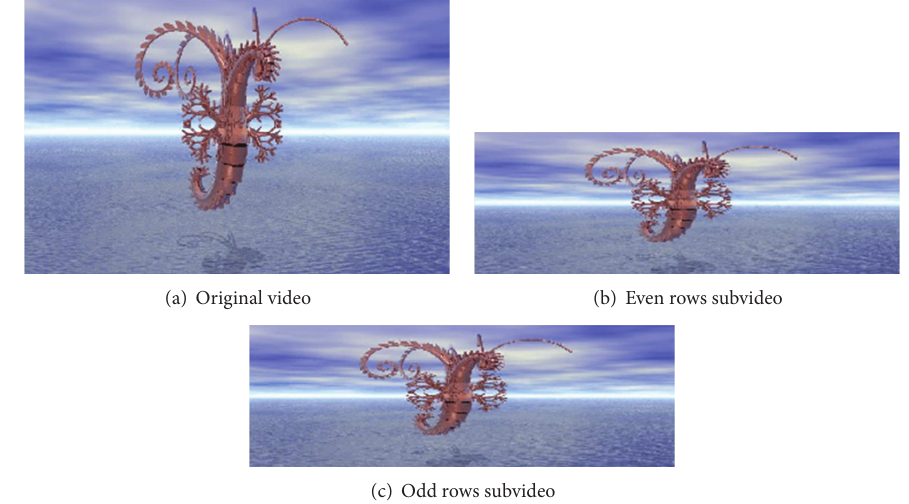
Figure 7: One-level interlacing by